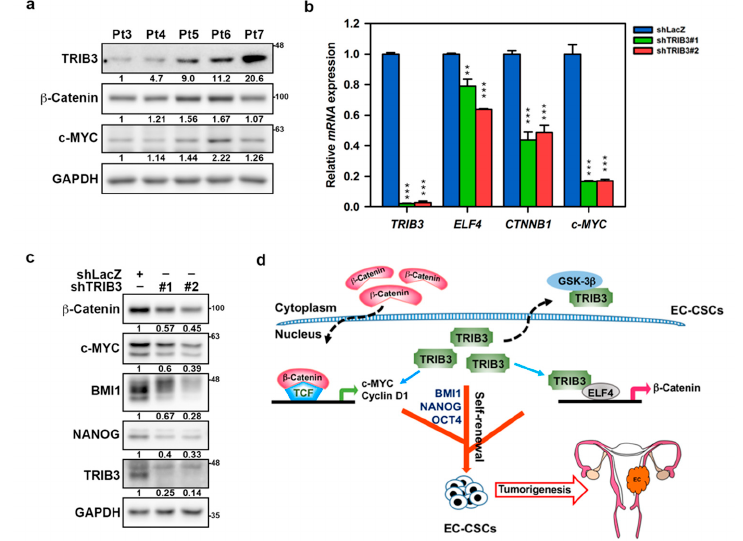
Figure 7. TRIB3 regulates the expression of β -catenin and other cancer stemness genes in patient-derived EC cells. ( a ) Specific amounts (25 µ g) of total cellular proteins from primary EC cells derived from five Taiwanese patients were used for examining the expression of TRIB3, c-Myc, and β -catenin by Western blot analysis. ( b , c ) EMC5 cells (established primary EC cells from patient No. 5 with clinical